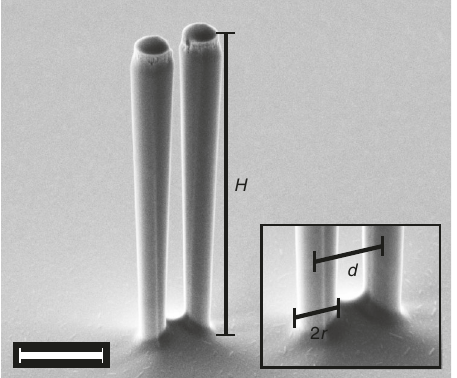
Fig. 1 Nanomechanical system. Scanning electron micrograph of a pair of nanopillar resonators with a height of H (cid:1) 7 μ m , a foot radius of r (cid:1) 310 nm and a center-to-center distance of d (cid:1) 1 : 1 μ m in a 60 (cid:3) tilted view. The taper angle of 1 : 1 (cid:3) gives rise to a somewhat larger head radius. Scale bar corresponds to 2 μ m . Inset shows a zoom of the clamping point of the two nanopillars